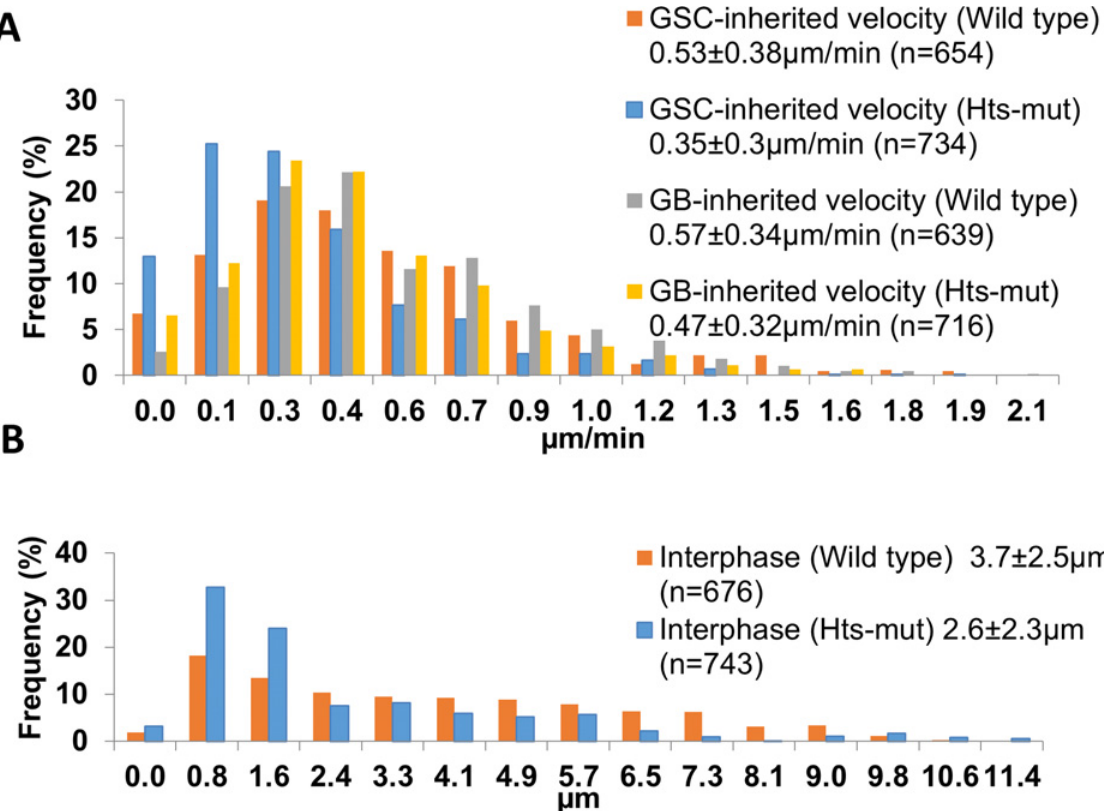
Fig 5. Centrosome velocity and distance to hub-GSC interface change in hts-mut GSCs. Based on the centrosome tracking analysis of live-image sequences, the A) Interphase centrosome velocities are shown for both hts-mut GSCs and wild type GSCs (p < 0.01 between hts-mut and wild type for both GSC-inherited and GB-inherited centrosomes), and the B) GSC-inherited centrosome distance to the hub-GSC interphase histograms are shown for both hts-mut and wild type GSCs (p <